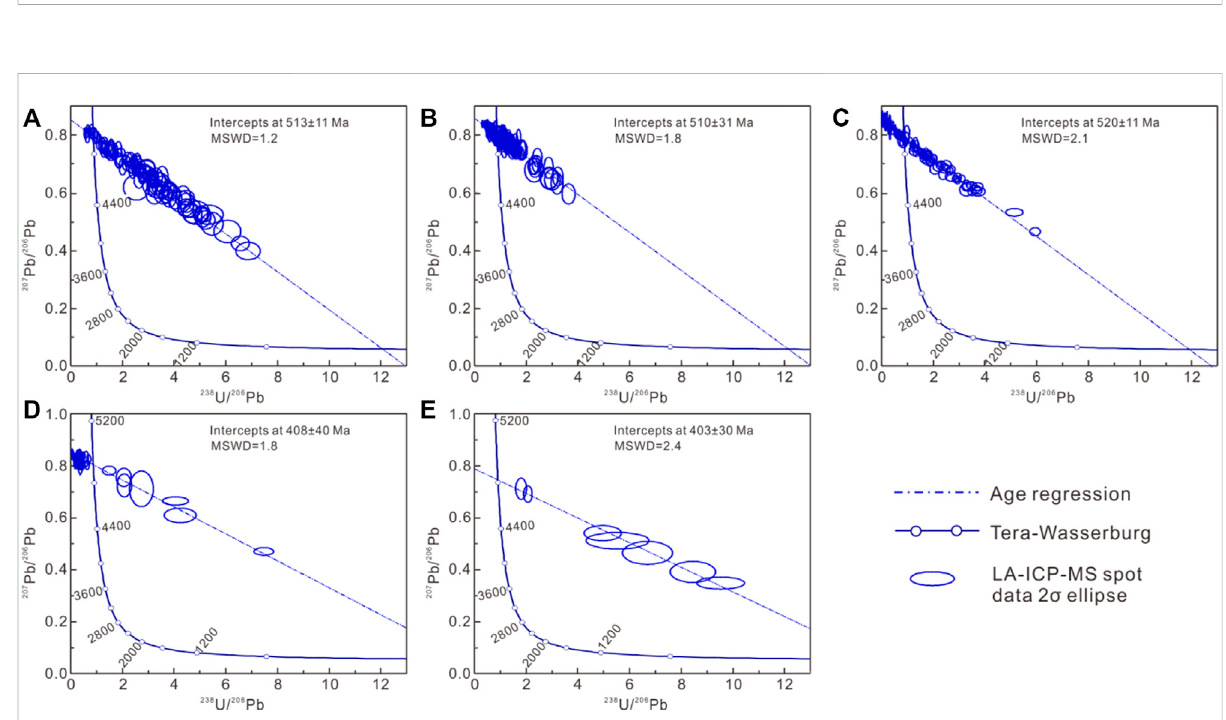
FIGURE 7 (A – C) Tera-WasserburgConcordiaplotsshowing 238 U/ 206 Pbvs. 207 Pb/ 206